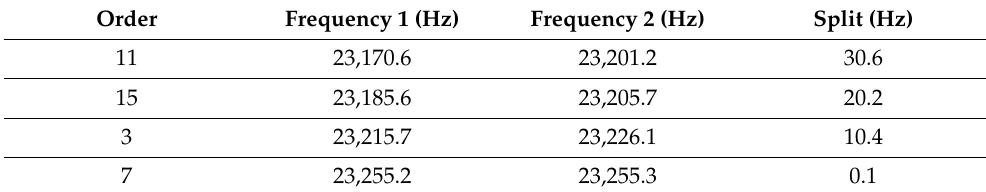
Table 2. Record of the frequency split for continuous punching holes at 90 ◦ intervals.